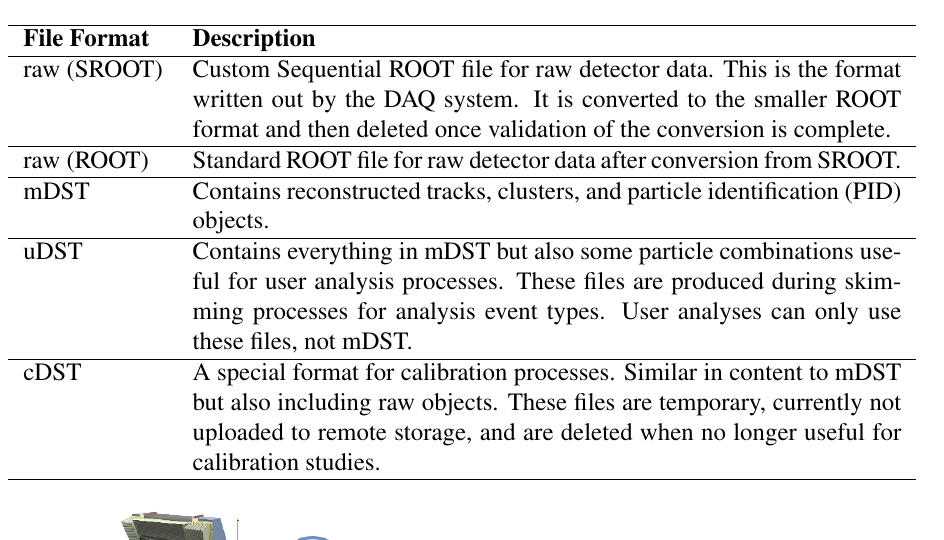
Table 2. Data file formats used in the Belle II data model. There are no specific MC file formats since basf2 can perform all the necessary steps in one process to generate mDST files with the extra MC truth objects included.